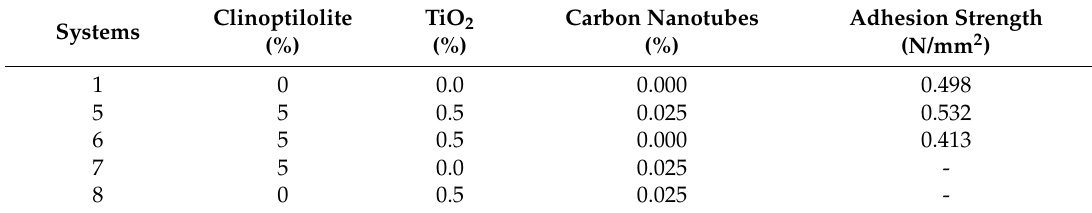
Table 9. Adhesion strength of mortars with a variable composition containing more additives.